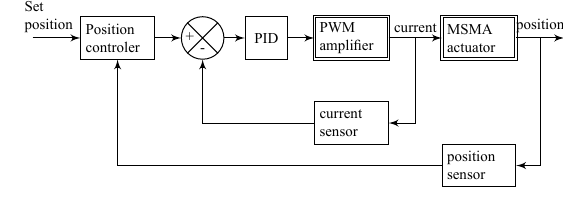
block-diagram of the feedback control with a “linear” cur- rent control (without current pulse control). This feedback control is enough to give a positioning precision of a few micrometers.